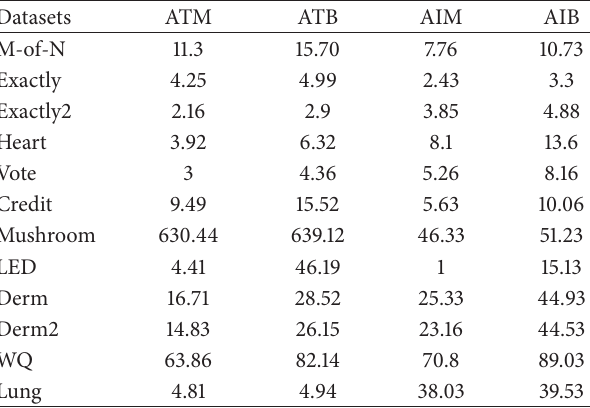
Table 2: Average iterations and runtimes to obtain the best known